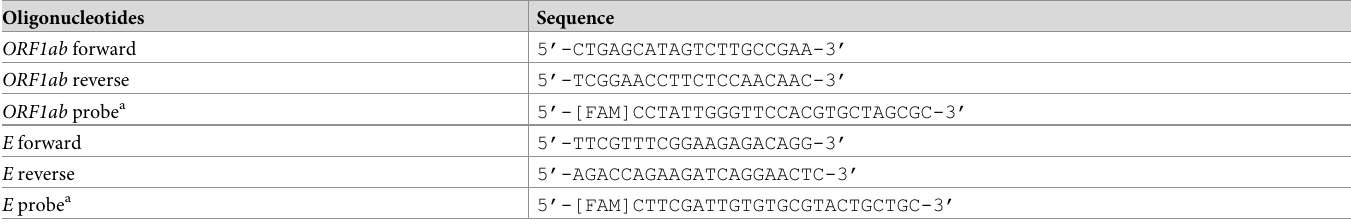
Table 1. Sequences of the droplet digital PCR primers and probes used for detection of SARS-CoV-2 genes.